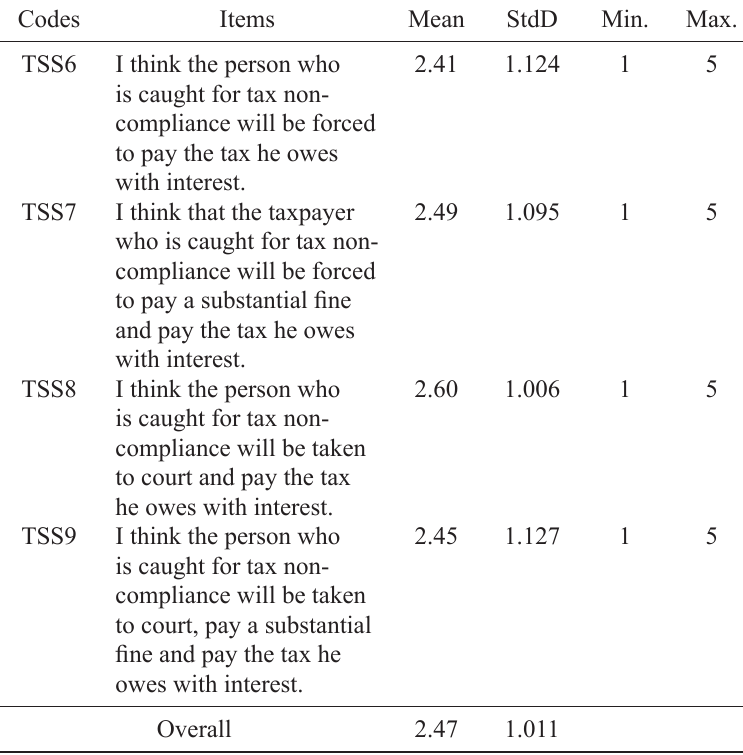
Descriptive Statistics of Penalties Codes Items Mean StdD Min.